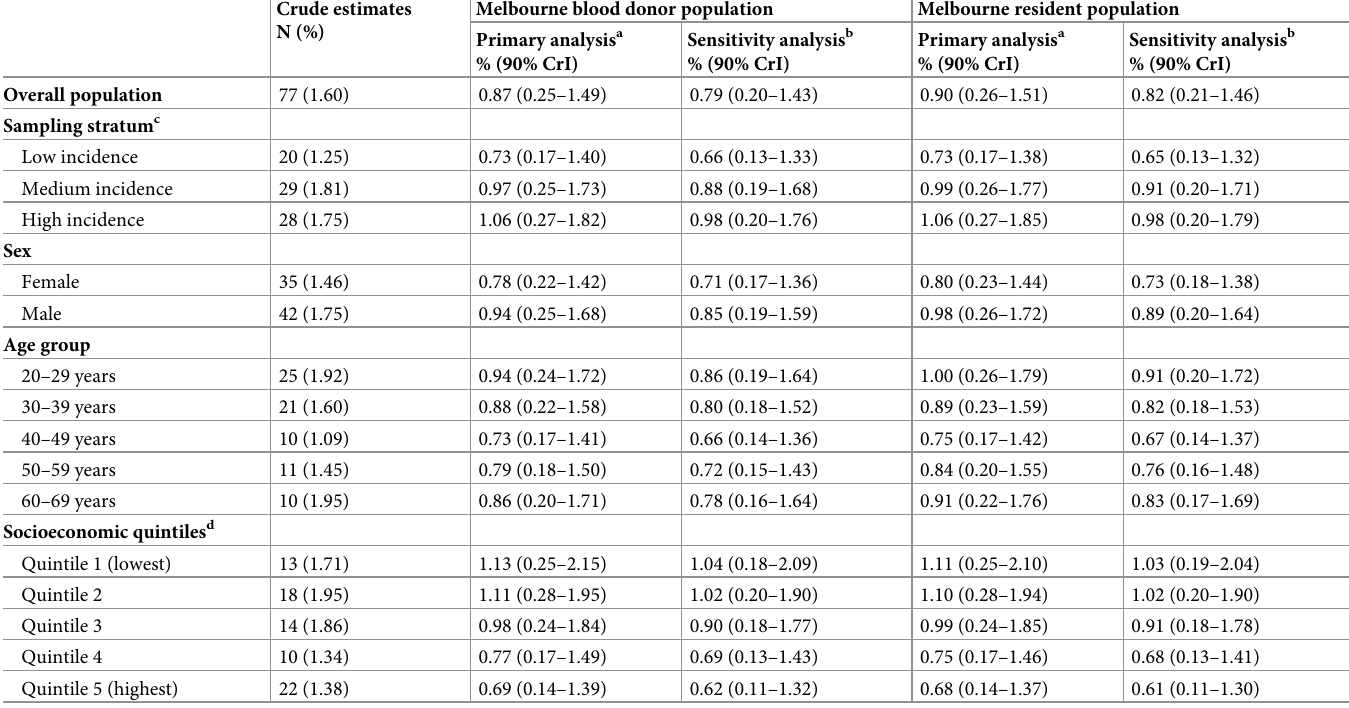
Table 2. Crude and estimated SARS-CoV-2 seroprevalence and 90% credible intervals (CrI) for the Melbourne blood donor population (A) and metropolitan Mel- bourne resident population (B) aged 20–69 years.